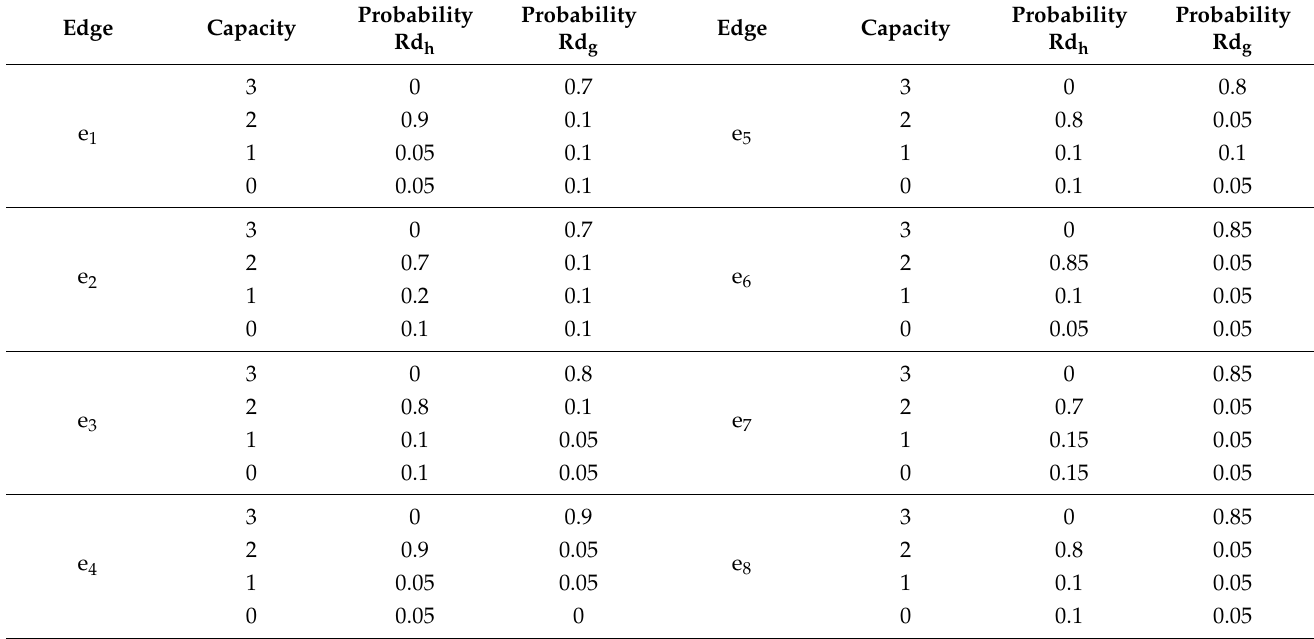
Table 2. The probability of the loading capacity of the two road types for each edge of Figure 6.